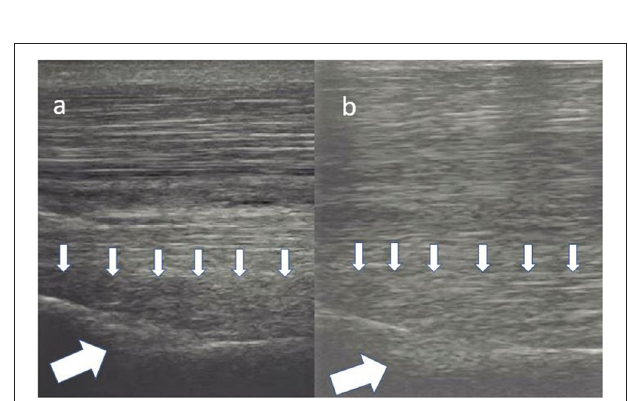
FIGURE 8 | Longitudinal images of a proximal suspensory ligament treated with LR-PRP. The lesion in panel (a) is characterised by at least 50% loss of the fibre pattern of the dorsal area of the ligament (small arrows). There is also a hypoechogenic area in the bony contour of the MTII (big white arrow). In panel (b) , there is re-appearance of the fibres in the lesion (small arrows). The echogenicity in the plantar contour of MTIII is increased. This horse was sound on evaluation 18 months after the